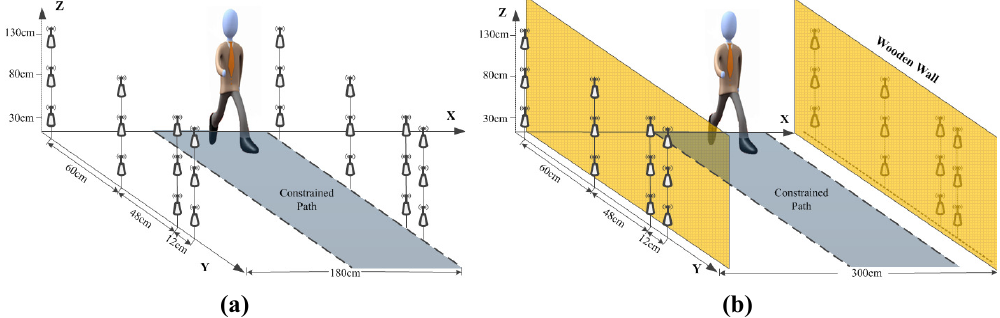
Figure 1. Multi-layer sensing model. ( a ) line-of-sight (LOS) scenario; ( b ) non-line-of-sight (NLOS) scenario.